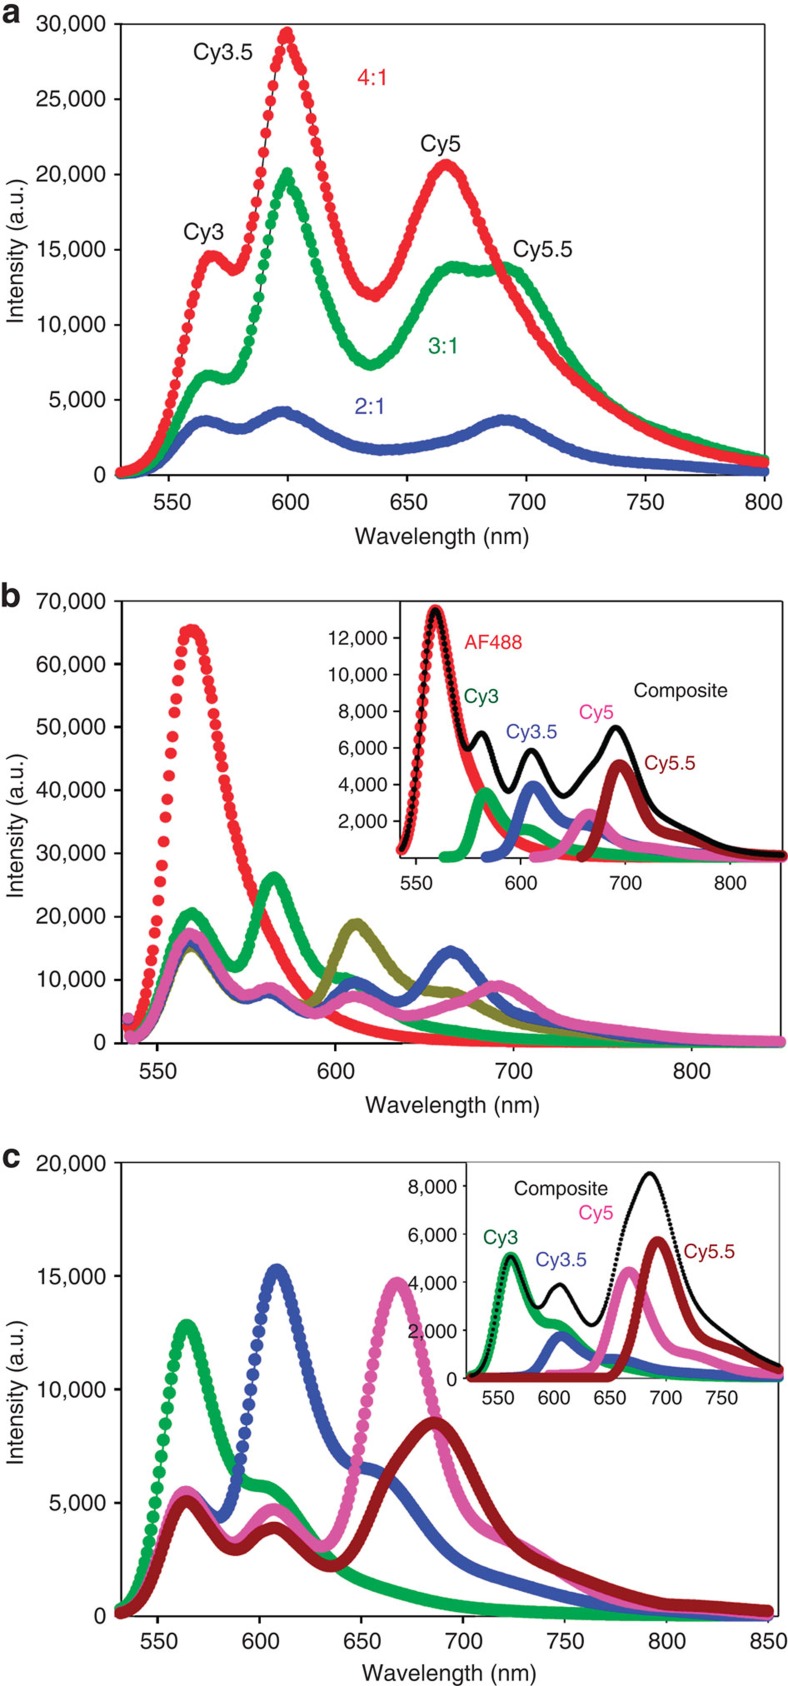
Four-dye and five-dye-branched dendrimer systems.(a) Representative comparative spectral data for the fully assembled 2:1, 3:1, and 4:1 0.5 × R0 dendrimer structures. Dye stoichiometries for dendrimer structures: 2:1=Cy38→Cy3.54→Cy52→Cy5.51; 3:1=Cy327→Cy3.53→Cy53→Cy5.51 and 4:1=Cy364→Cy3.516→Cy54→Cy5.51. Note: all data in a–c were normalized to the direct Cy5.5 emission. (b) Representative spectral data following the evolution of the five-dye 2:1 0.5 × R0 dendrimer AF48816→Cy38→Cy3.54→Cy52→Cy5.51 system. Constructs with dyes present and their corresponding colours are AF488 only (red), AF488→Cy3 (green), AF488→Cy5 (olive), AF488→Cy3 (navy) and AF488→Cy5.5 (pink). (c) Representative four-dye 0.5 × R0 Cy38→Cy3.54→Cy52→Cy5.51 2:1 dendrimer systems. Constructs with dyes present and their corresponding colours are Cy3 only (green), Cy3→Cy3.5 (navy), Cy3→Cy5 (pink) and Cy3→Cy5.5 (brown). The construct in c has the Cy3.5 ester dye replaced by a Cy3.5 phosphoramidite within the oligos. Inset in b,c shows the spectra of fully formed structure along with each of the contributing component dyes. Constructs with Cy3 as the initial dye were excited at 515 nm, while those with AF488 were excited at 465 nm.